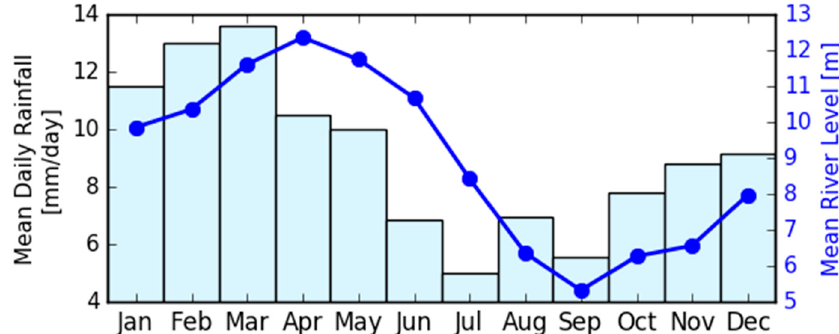
Figure 2. Mean monthly rainfall rate (mm/day) and mean monthly river level observed at Nauta field station (4°30’26.5”, 73°34’23.88”W), derived from daily observations over 2012–2017 provided by Servicio Nacional de Meteorologia e Hidrologia (Peru) [33].